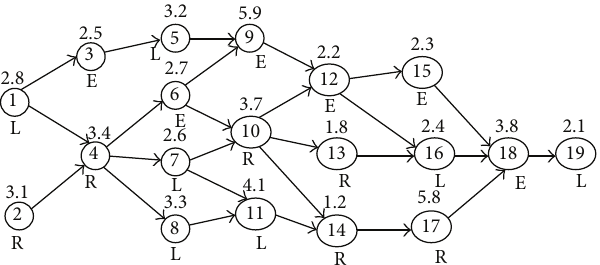
Figure 2: Frame work of the EHA.